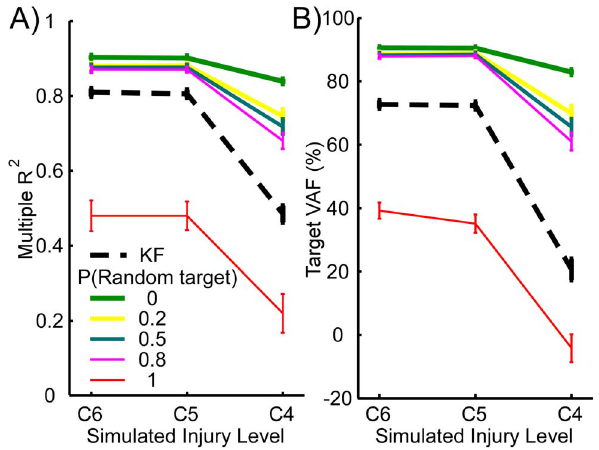
Figure 3. Accuracy with standard errors of A) trajectory and B) target reconstructions for the generic KF, and the mKFT with different prior probabilities assigned to the correct and random targets, with varying the amount of available EMG to simulate different levels of SCI.